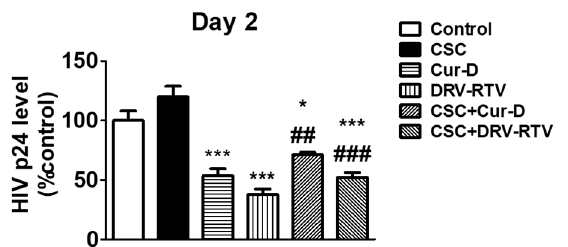
Figure 4. Comparison of the anti-HIV effect of Cur-D with darunavir/ritonavir (DRV/RTV): To compare the anti-HIV effect of Cur-D with DRV/RTV on cigarette smoke condensate (CSC)-induced viral replication, differentiated U1 macrophages were treated with Control (DMSO), CSC (10 µg/mL), Cur-D (0.1 µM), and DRV-RTV (3 µg/mL/1 µg/mL) and observed for 2 days. HIV viral loads from media of U1 cells were measured on day 2, using a p24 ELISA kit. One-way ANOVA with Tukey’s post-hoc test was applied to compare between multiple groups. * and *** represent p < 0.05, and p ≤ 0.001, respectively, when compared to control. ## and ### represent , p ≤ 0.01 and p ≤ 0.001, respectively when compared to CSC.